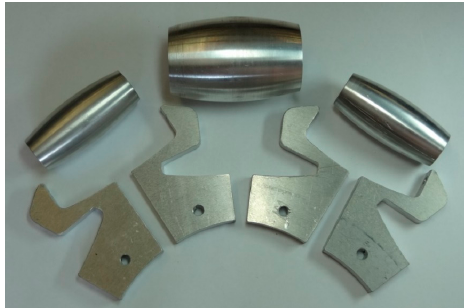
Figure 7. Exploded view of the basic components of the wheel.